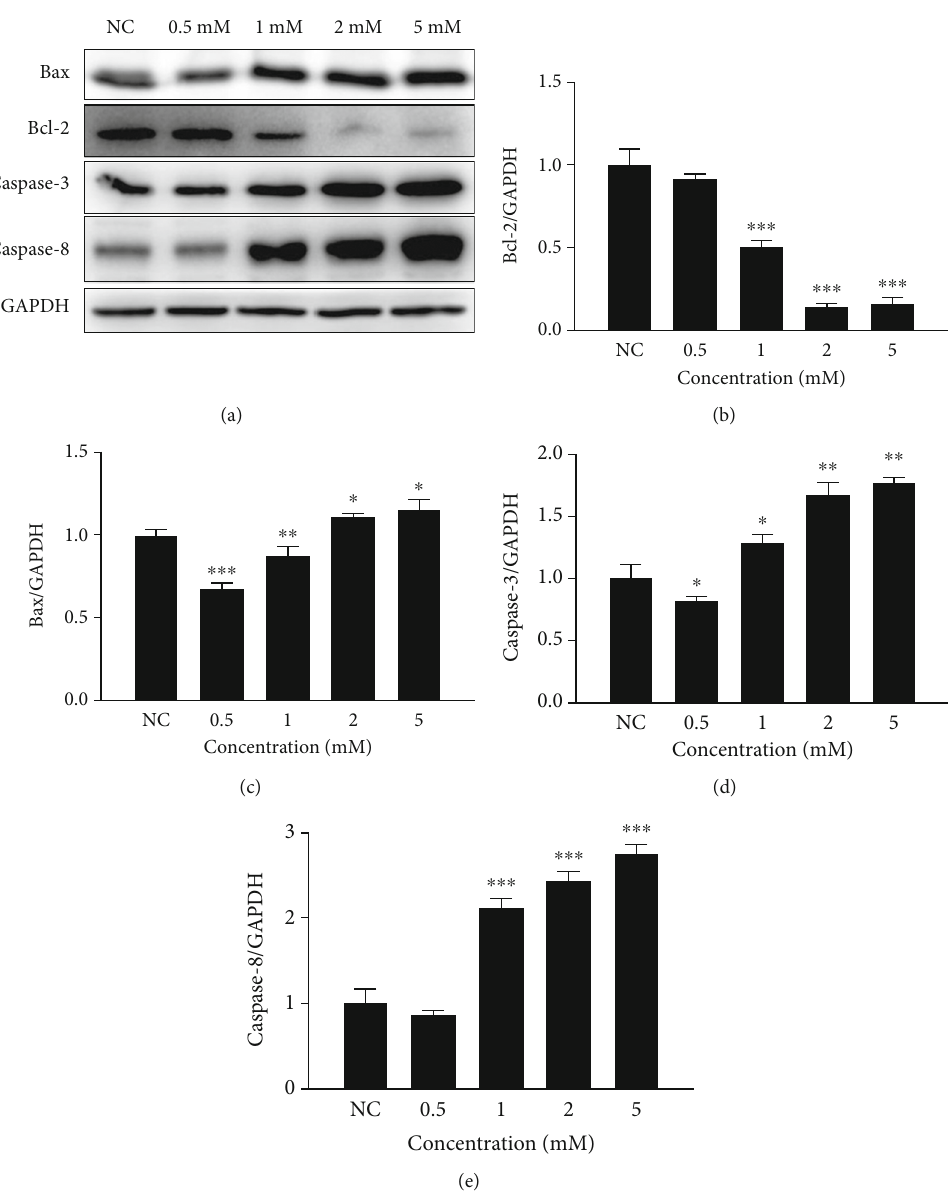
Figure 1: Neomycin-induced apoptotic protein expression at di ff erent concentrations. (a) Four apoptotic-related protein (Bax, Bcl2, caspase-3, and caspase-8) expressions were detected by Western blot in HEI-OC1 cells treated with 0.5, 1.0, 2.0, and 5.0mM neomycin. The expression levels of Bcl-2 (b), Bax (c), caspase-3 (d), and caspase-8 (e) were normalized to GAPDH at di ff erent concentrations of neomycin. One-way ANOVA, ∗ p < 0 : 05 , ∗∗ p < 0 : 01 , and ∗∗∗ p < 0 : 001 , versus the normal control. All tests were repeated three times